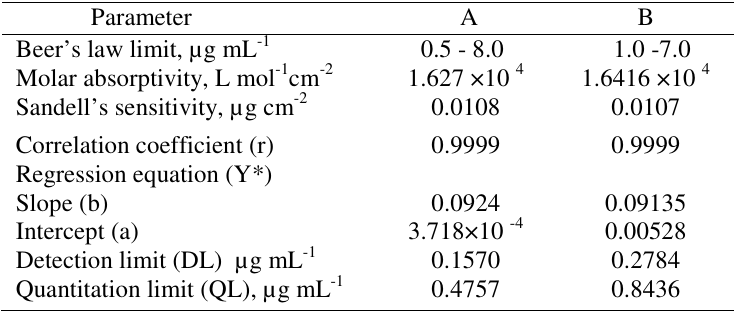
Table1. Optical characteristics and precision data